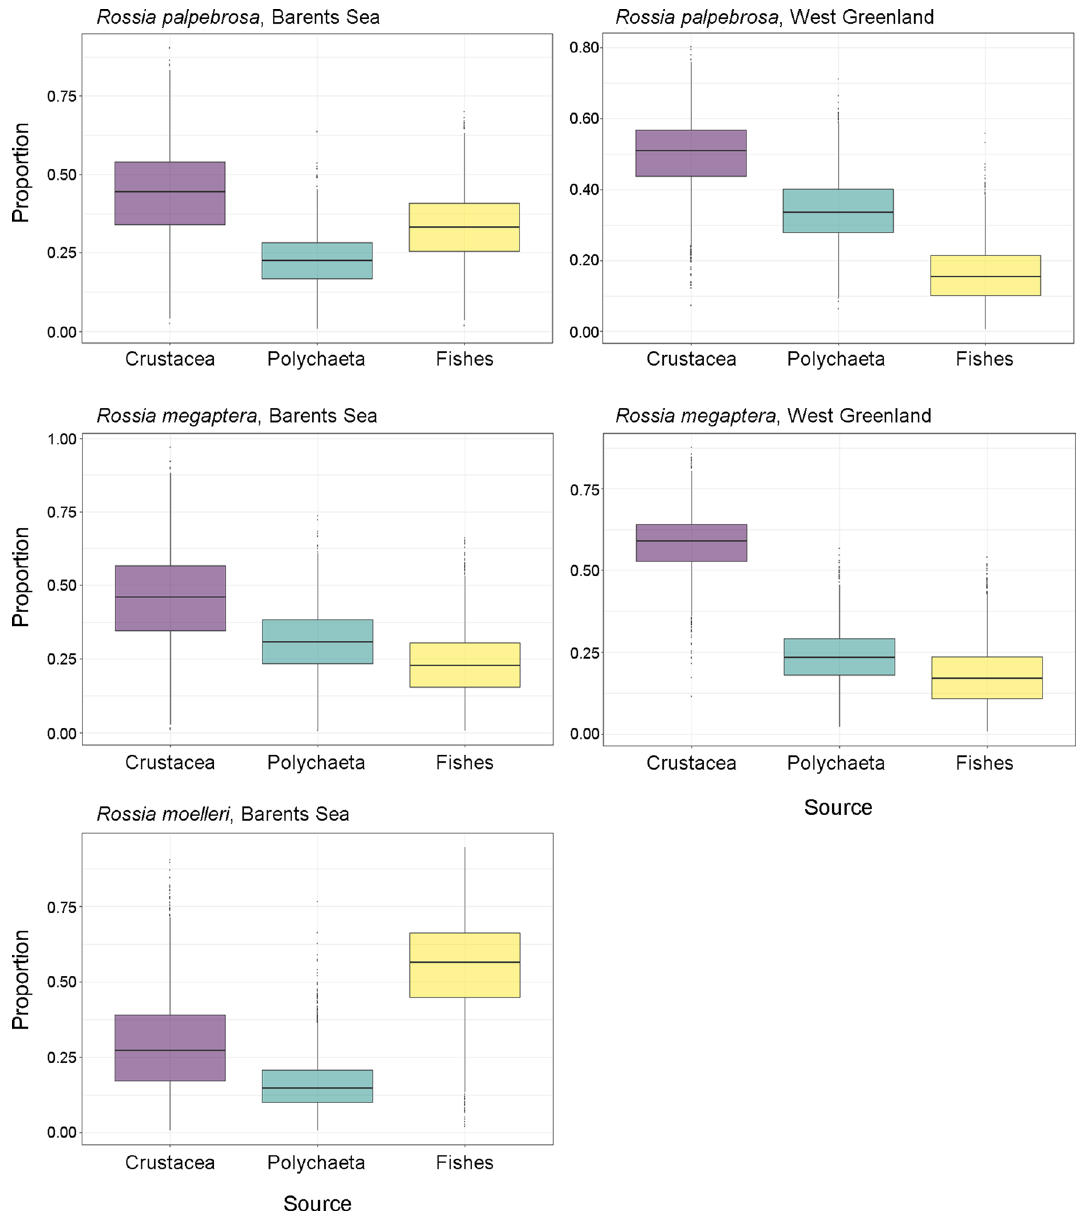
Figure 2. Relative contribution of prey to the diet (mean, box 25% and 75% percentiles, whiskers 5% and 95% percentiles) of the studied species of the genus Rossia predicted by Bayesian mixing model SIMMR